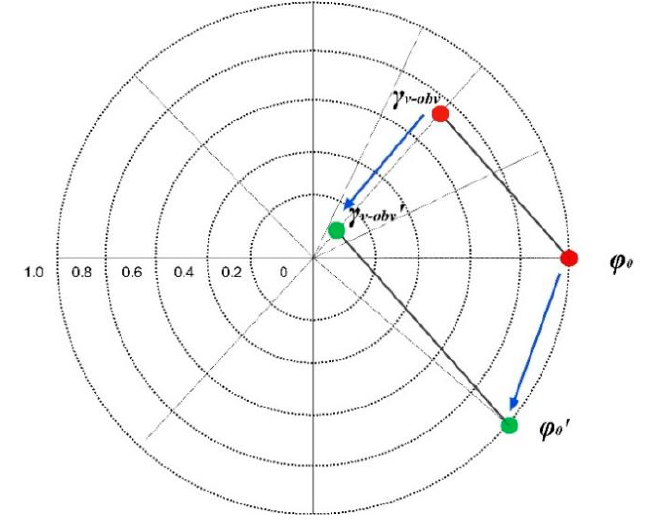
Figure 4. Schematic diagram illustrating volume coherence and ground phase variation.